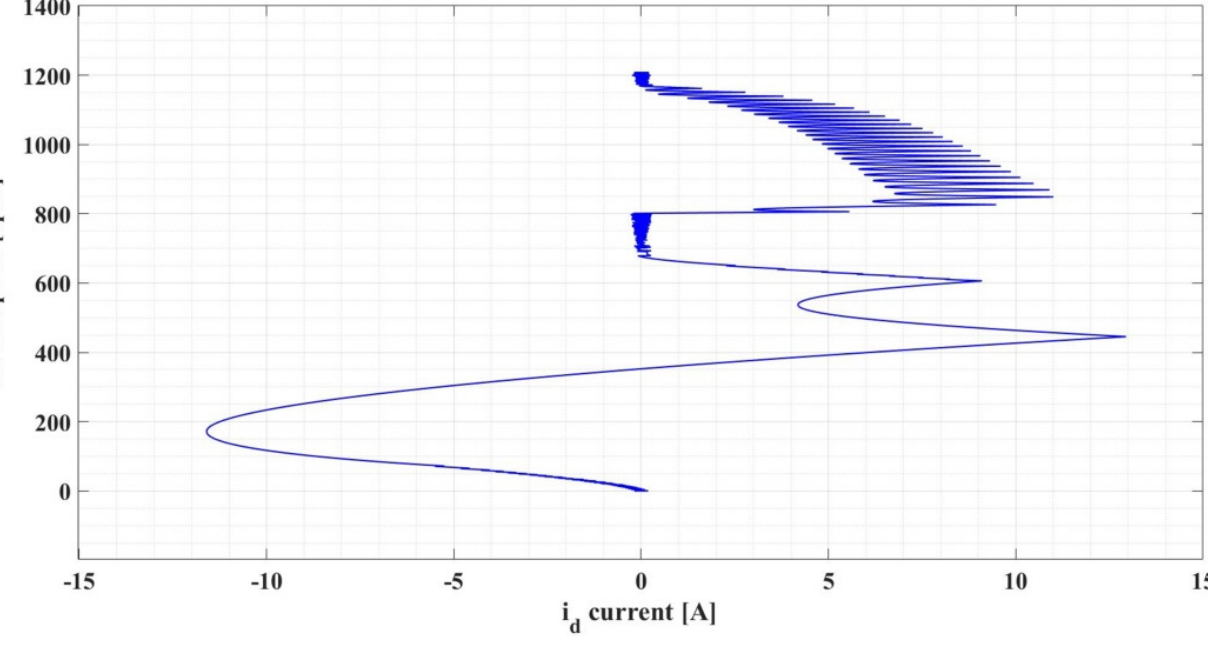
Figure 29. Image of the phase plan for PMSM variable structure with switching signal type 2: rotor speed versus i d current ( ω ref = [800, 1200] rpm).